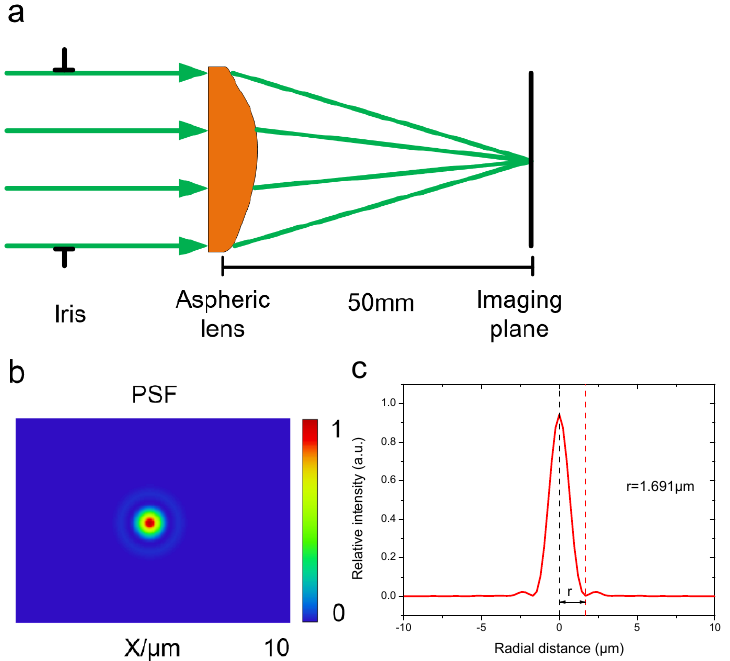
Figure 2. ( a ) Diagrammatic sketch of an optimal aspheric lens. ( b ) The 2D point spread function on the image plane. ( c ) The intensity profile of the point spread function of the designed